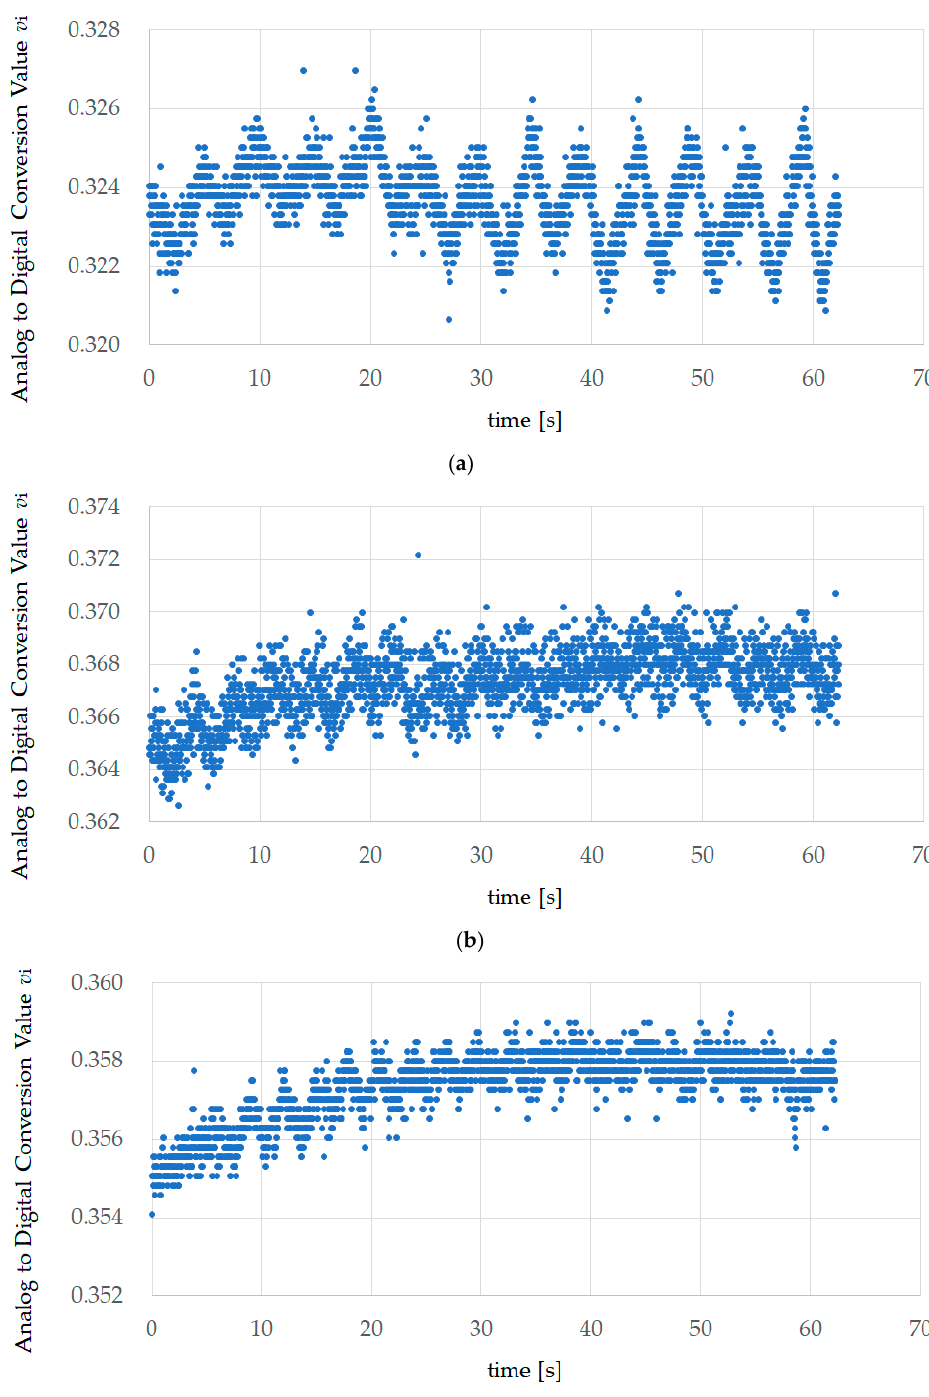
Figure 4. Experiment results of EX200mHz12rpm, EX267mHz16rpm, and EX333mHz20rpm for subject A. This value is the analog–digital (AD) converted value v i measured using the sensor. A.D. conversion occurred with a sampling frequency of 34.13 Hz and a resolution of 12 bits, and the number of data items was 2129. The measurement time was approximately 62.37 s. ( a ) The first experiment results of 200 mHz (EX200mHz12rpm); ( b ) the first experiment results of 267 mHz (EX267mHz16rpm); ( c ) the first experiment results of 333 mHz (EX333mHz20rpm).